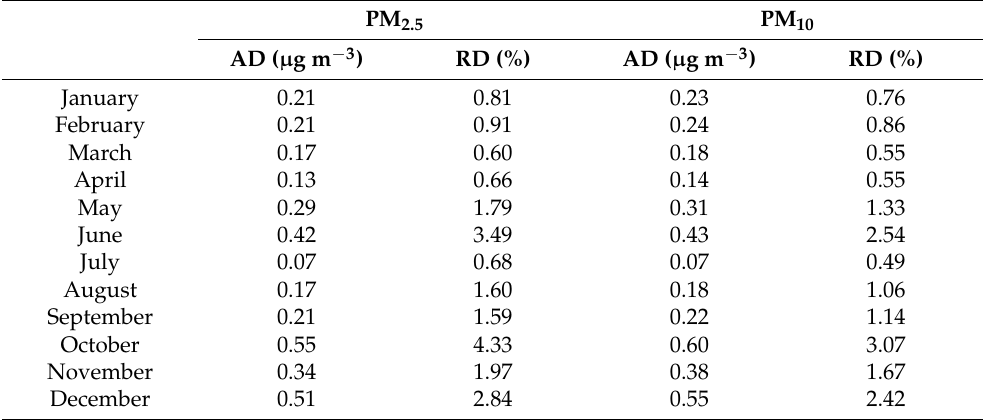
Table 4. Impacts of crop residue burning on the monthly concentrations of particulate matters over South Korea, in terms of absolute (AD) and relative differences